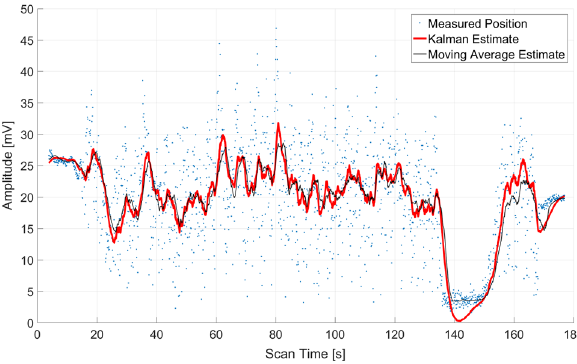
Fig. 18 Visual analytics concept showing mine structure based on laser point cloud overlaid with radar